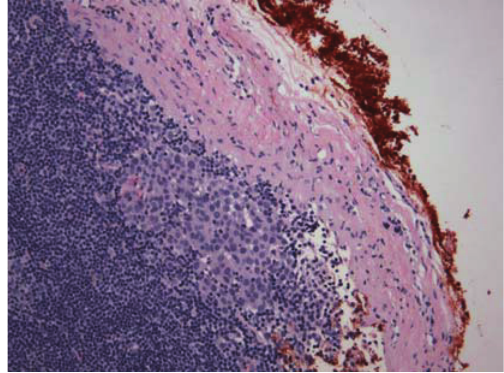
Figure 1: Micrometastases located in cortex close to hotspot.